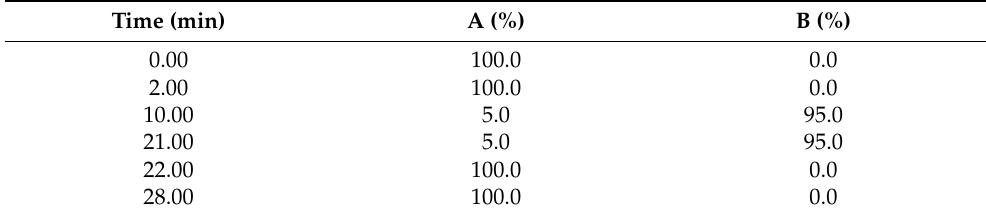
Table 2. Gradients used at the flow of 1 mL min − 1 for the separation of the compounds on the column. Time (min) A (%) B (%) 0.00 100.0